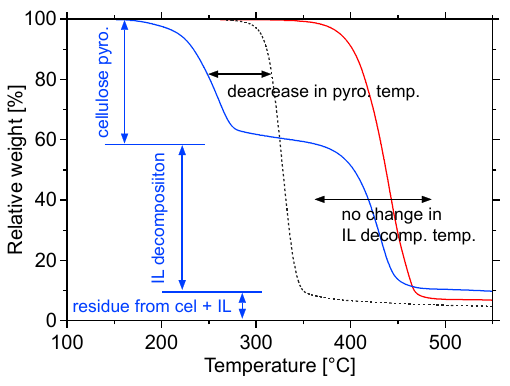
Figure 4. Characteristic weight loss curve for cellulose/sulfonate IL mixture (blue line: 50% ( w / w ) mixture, red line: IL and dashed black line: cellulose).